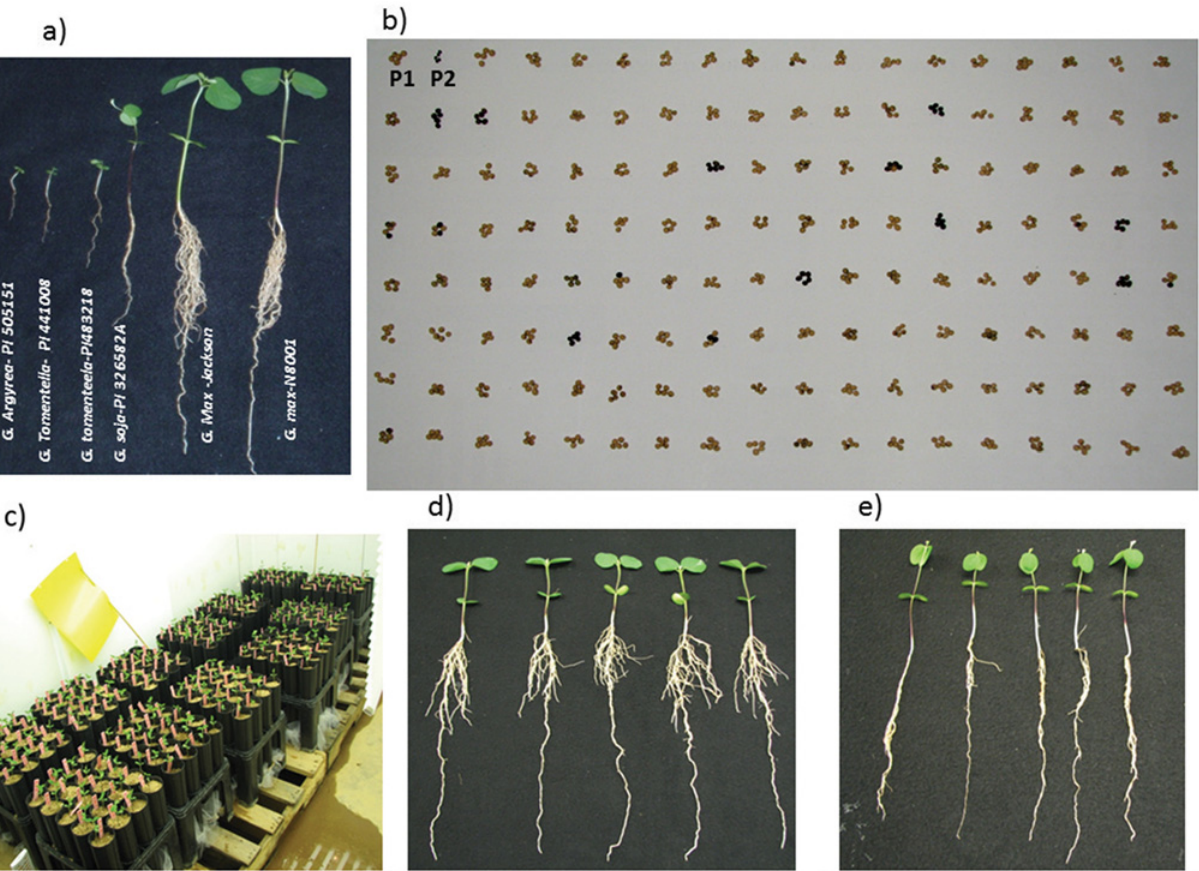
Fig 1. Variation for seed and plant architectural traits in soybean and the BIL population. a) Variation in root architecture in soybean accessions 12 days after sowing (das); b) Seed coat color of parents (Dunbar, P1 and PI 326582A, P2) and RILs c) Cone system for root screening d) Dunbar 12 das e) PI 326582A 12